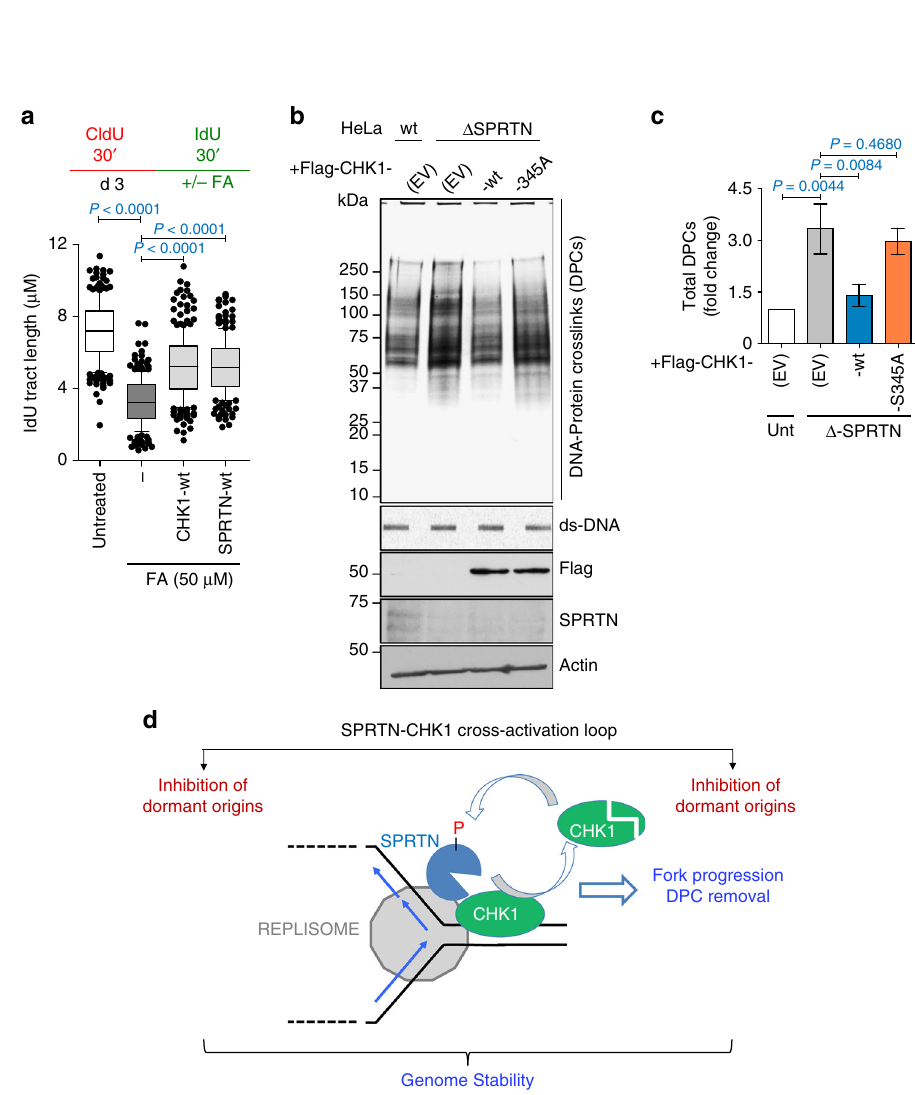
Fig. 8 CHK1 and SPRTN promote replication fork progression by removing DPCs. a Ectopic expression of CHK1-wt or of SPRTN-wt promotes replication fork progression over FA-induced DPCs in HEK293 cells. Upper panel shows the strategy for DNA fi ber assay. Lower graph plots the quanti fi cation of IdU tract length. >100 DNA fi bers were analysed per condition and experiment. Mean ± 25 – 75 percentile range (box) ± 10 – 90 percentile range (whiskers), n = 3 experiments, two-tailed Student's t -test. b , c Overexpression of CHK1-wt, but not of CHK1-S345A, reduces the amount of DPCs in HeLa- Δ SPRTN cells. DNA protein crosslink extracts were visualised by silver staining ( b ). ds-DNA blot is shown as a loading control. The immunoblots for Flag, SPRTN and actin were prepared from whole cell lysates. Data are representative immunoblots ( b ) and quanti fi cation of CHK1 on chromatin fraction normalised to histone H2B ( c ). Mean ± SEM; n = 3 experimental replicates, two-tailed Student's t -test. d Model for the SPRTN-CHK1 cross-activation loop. During steady-state DNA replication, SPRTN evicts CHK1 from replicative chromatin and stimulates CHK1 activity. In turn, CHK1 phosphorylates SPRTN on C- terminal serines. CHK1 activity enhances the recruitment of SPRTN to chromatin and its activity towards DPC proteolysis. This steady-state SPRTN-CHK1 cross-activation loop enables normal physiological replication fork velocity, inhibits unscheduled replication origins fi ring, stabilises replication forks and removes DPCs to safeguard genome stability. Source data for ( a – c ) are provided as a Source Data fi